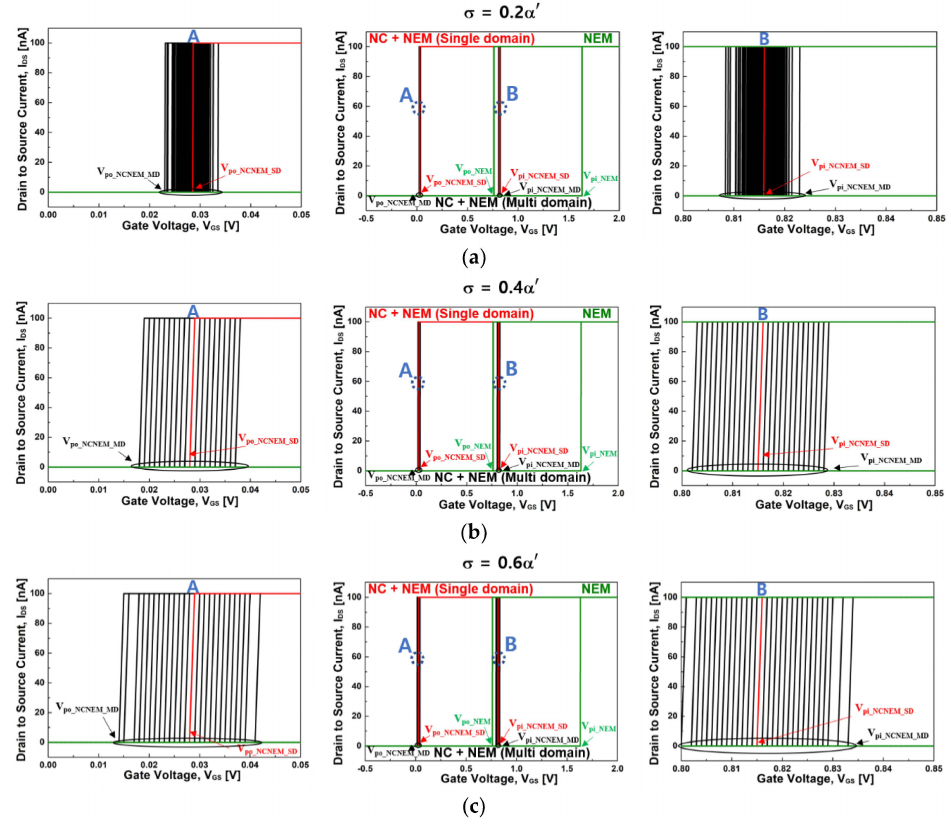
Figure6. Simulateddraintosourcecurrentvs. gatevoltageofNEMrelay, NEMrelaywithsingle-domain ferroelectric and NEM relay with multi-domain ferroelectric with various domain inhomogeneities (i.e., ( a ) σ = 0.2 α (cid:48) ; ( b ) σ = 0.4 α (cid:48) and ( c ) σ = 0.6 α (cid:48)